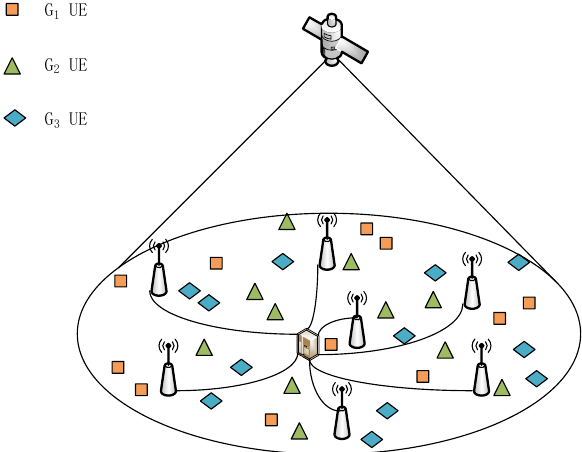
Figure 1. System